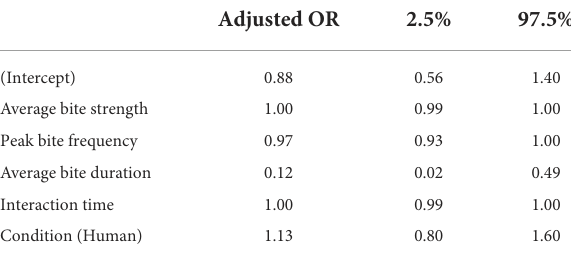
TABLE 2 Adjusted odds ratios of the general linear model for CCI